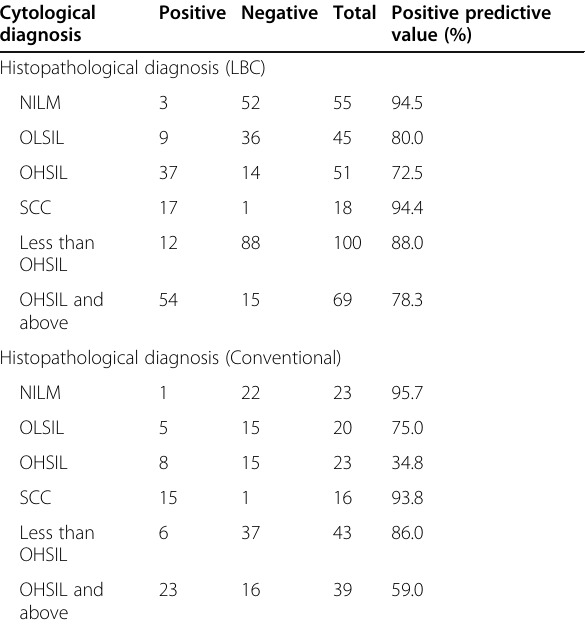
Table 3 Diagnostic accuracy of LBC and conventional methods Cytological diagnosis